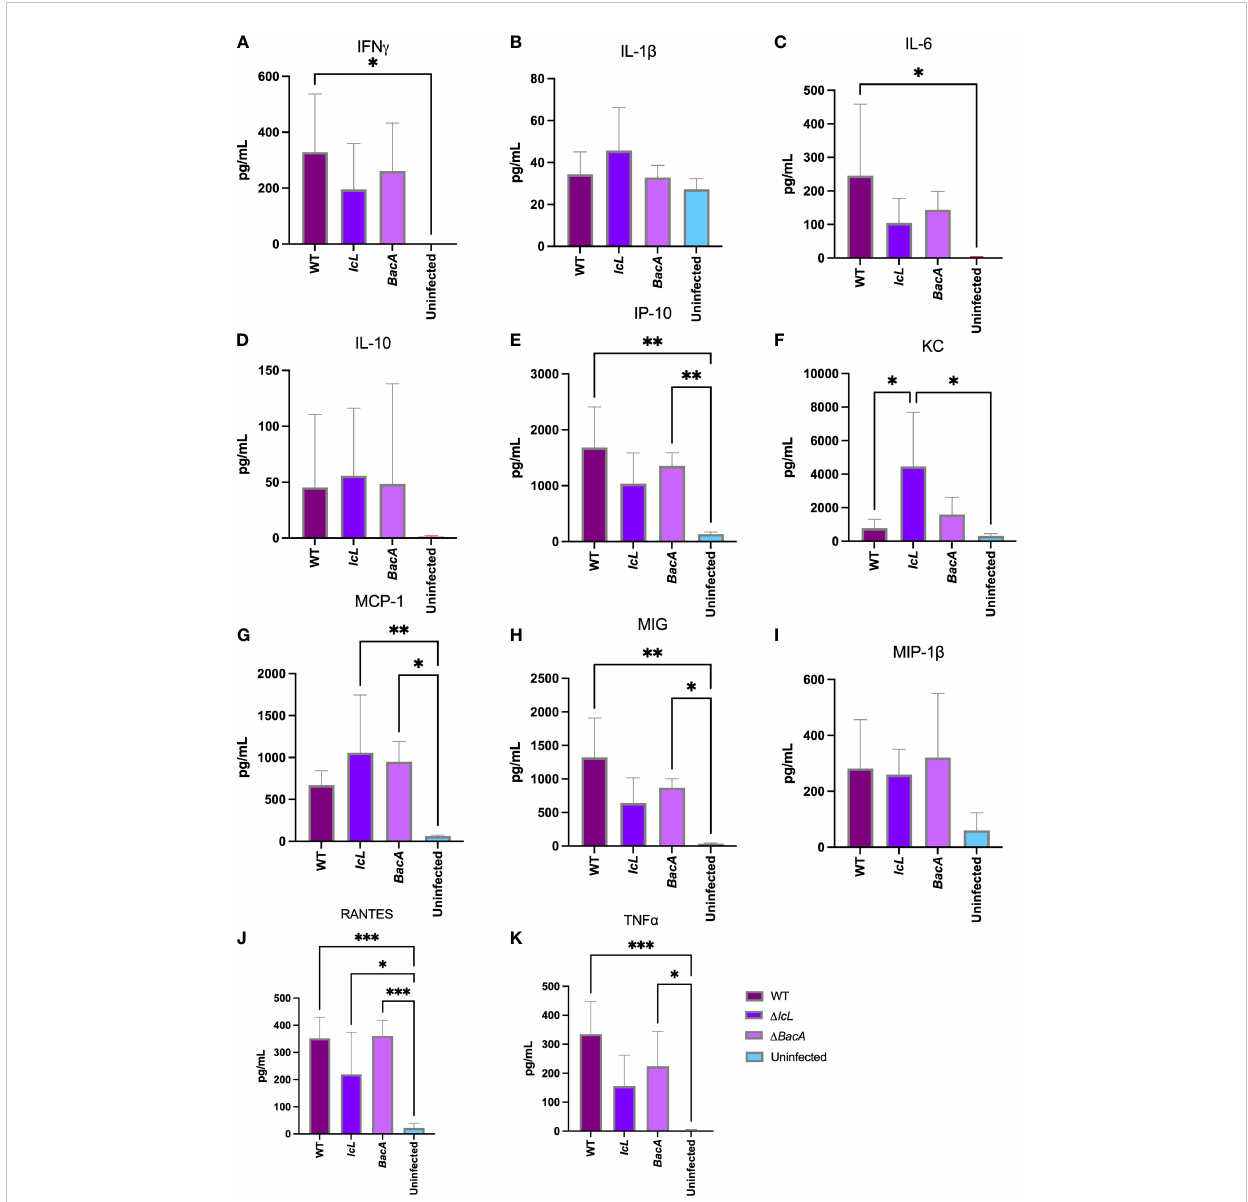
FIGURE 4 Analysis of cytokine secretion in mice (n=14/group) serum three weeks after intraperitoneal infection with 5×10 8 CFU of MAP wild-type and mutant strains. The uninfected control received PBS. The secretion level of cytokines in the serum were measured by Luminex assay. The difference among groups were assessed by one-way ANOVA and then further validated by Tukey-Kramer test. * P ≤ 0.05; ** P ≤ 0.01; *** P ≤